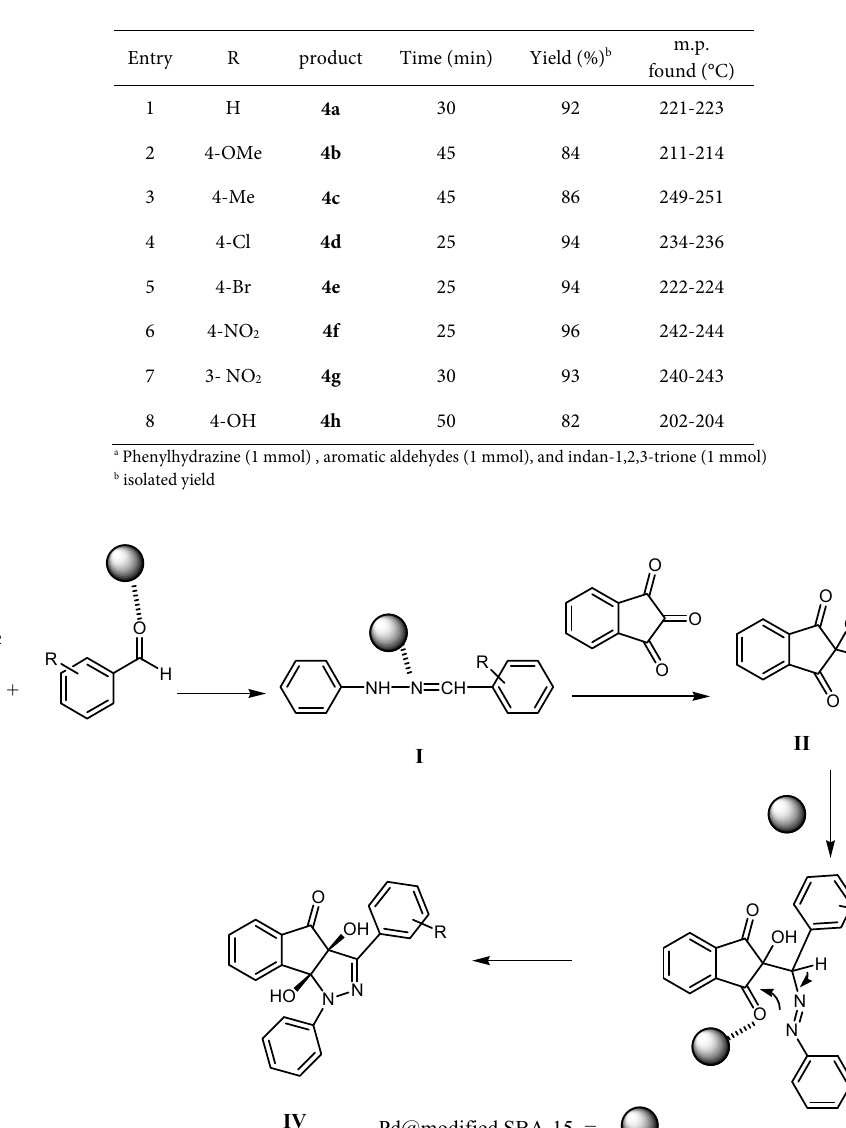
Scheme 3. Proposed mechanism for the synthesis of